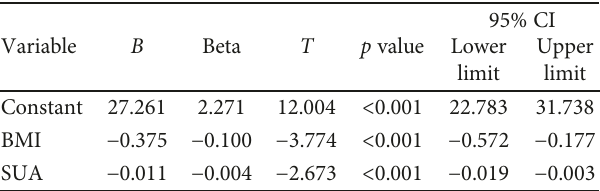
Table 5: Multivariate regression analysis of male